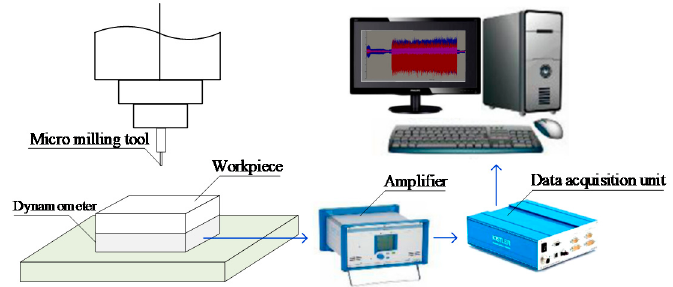
Figure 5. Experimental setup.